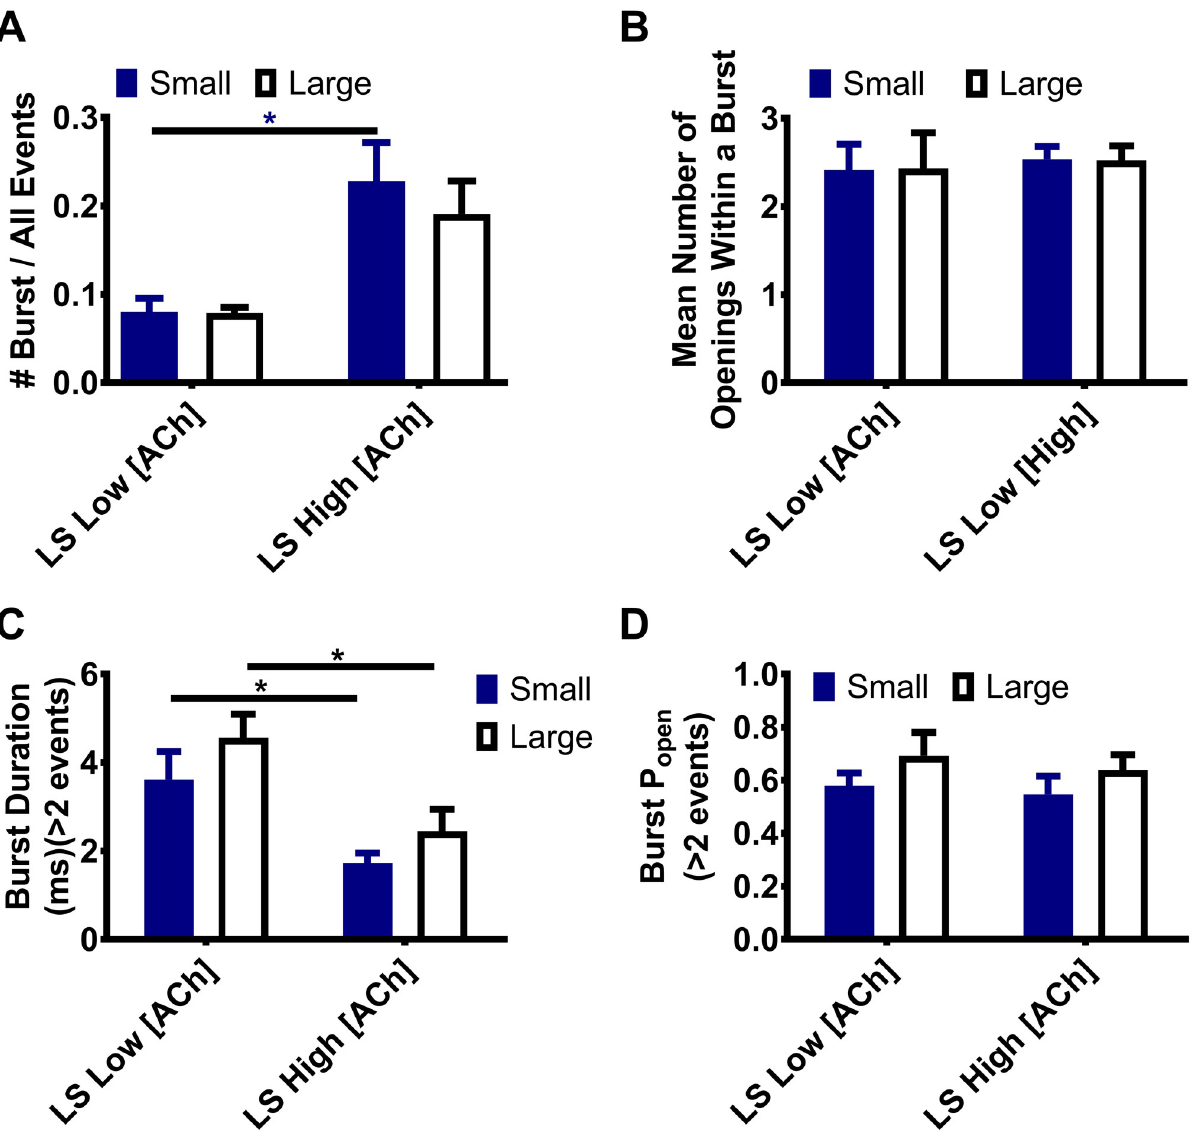
Fig 11. Human LS α 4 β 2-nAChR small and large amplitude burst parameters. LS α 4 β 2-nAChR isoforms were expressed in X . laevis oocytes using unlinked subunits and burst parameters were measured. Comparisons were made using Student’s two-tailed, unpaired, t-tests (df = 9–11, significant differences noted at p < 0.05). A) The mean proportion of small or large amplitude openings falling within bursts, compared to the total number of each type of open event, was determined at a low ACh (0.7 μ M) and a high ACh (30 μ M) concentration. For both small and large amplitude openings, the proportion of events within bursts of the corresponding amplitude appeared to increase with application of a high ACh concentration. A significant increase in the small amplitude burst proportion was observed with a high ACh concentration compared to the low ACh concentration ( � ). B) The mean number of openings per burst of LS isoform small or large amplitude openings was determined at both the low and high ACh concentrations. Altering the concentration of ACh had no significant effect on the numbers of openings within either class of bursts. C) The durations of LS isoform small or large amplitude bursts were measured at the low and high ACh concentrations. Increasing the ACh concentration significantly shortened the duration of both small and large amplitude bursts ( � ). D) The P open within bursts was indistinguishable between bursts of small or large amplitude events, and was not significantly altered by an increase in applied ACh concentration from 0.7 μ M to 30 μ M. containing multiple open amplitudes were extremely rare ( < 0.05% of all events analyzed) and, in any case, were excluded from the analysis. As a result, the higher conductance state uniquely associated with LS ( α 4 β 2) 4-nAChR cannot be an artifact produced by multiple, 2 α smaller-conductance, channel openings occurring simultaneously. Further evidence that small